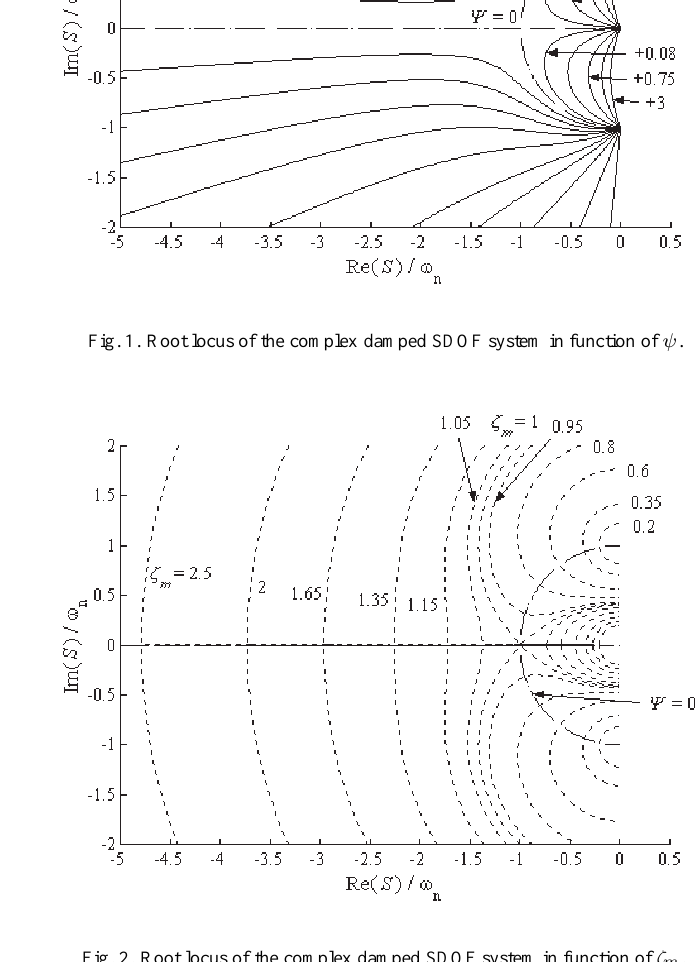
Fig. 2. Root locus of the complex damped SDOF system in function of ζ m